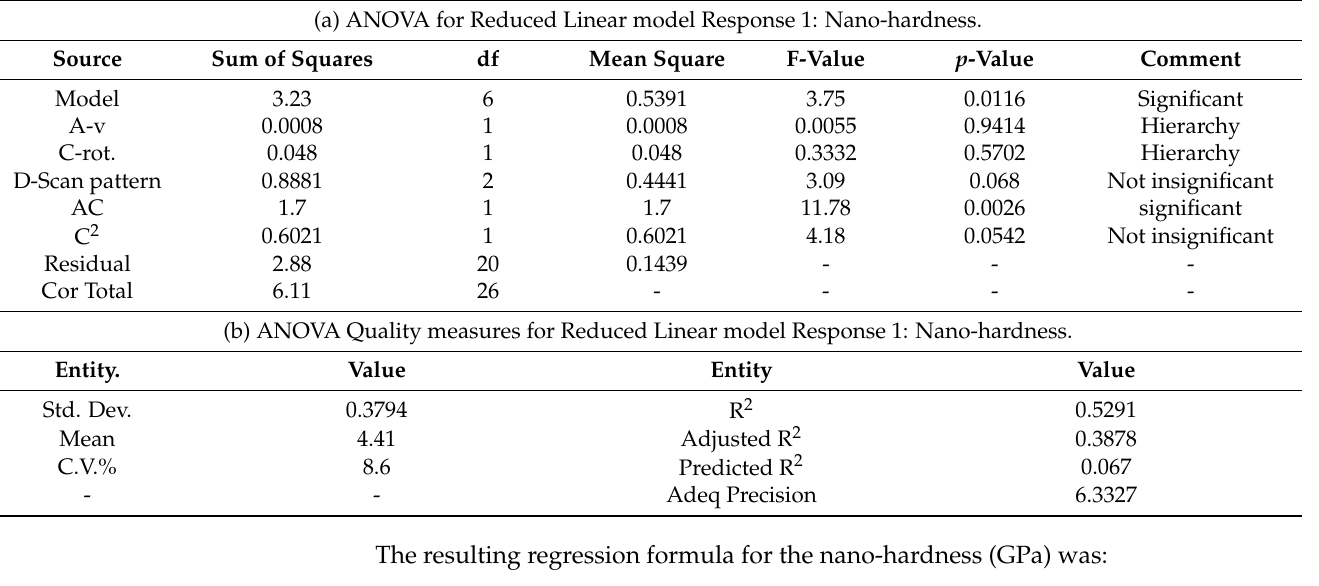
Table A4. ANOVA results: